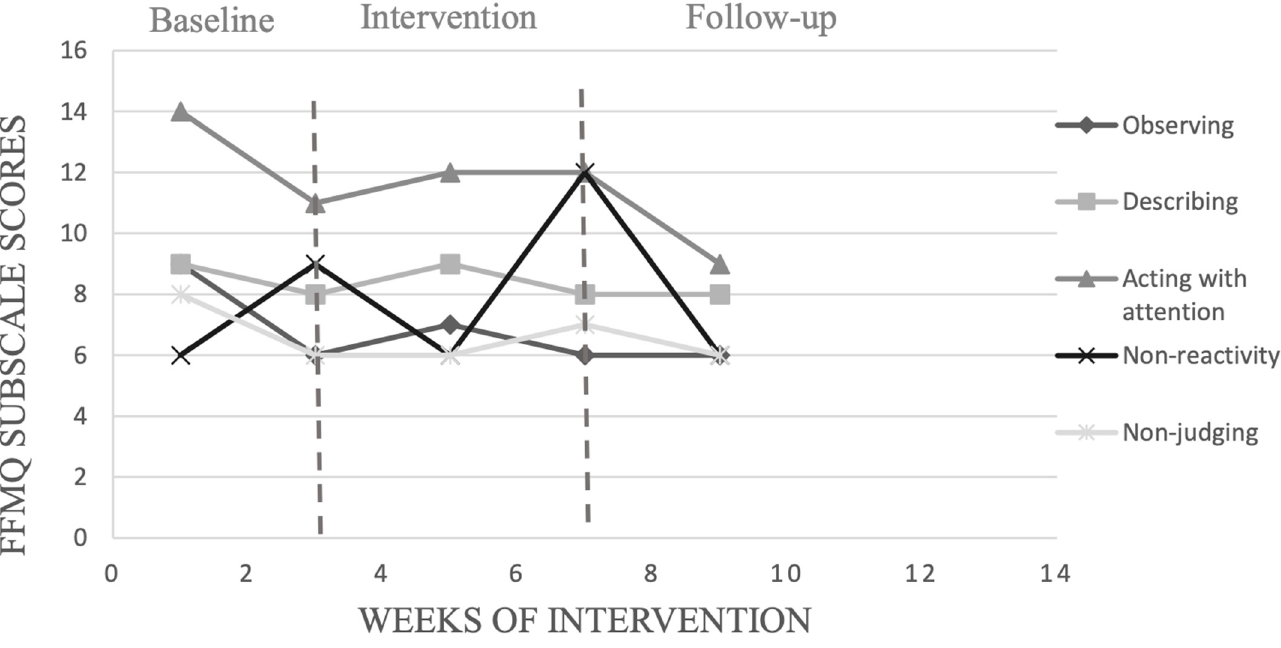
Figure 5. Evolution of scores obtained on the FFMQ by participant 10, across the weeks of interven- tions .